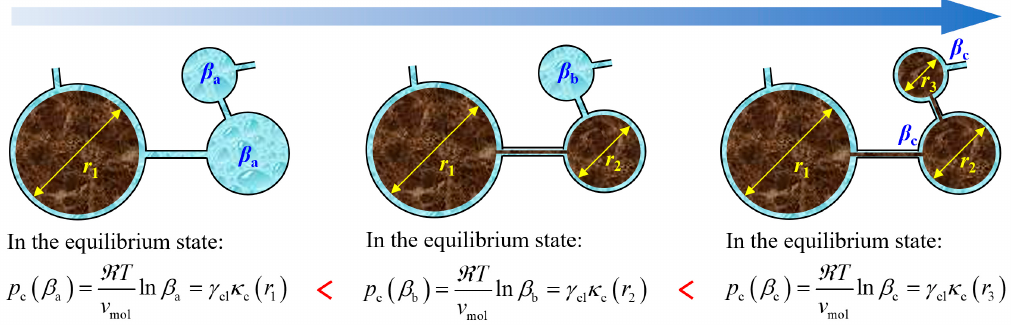
Figure 3. Filling behavior of ettringite crystal in pore system of local concrete.